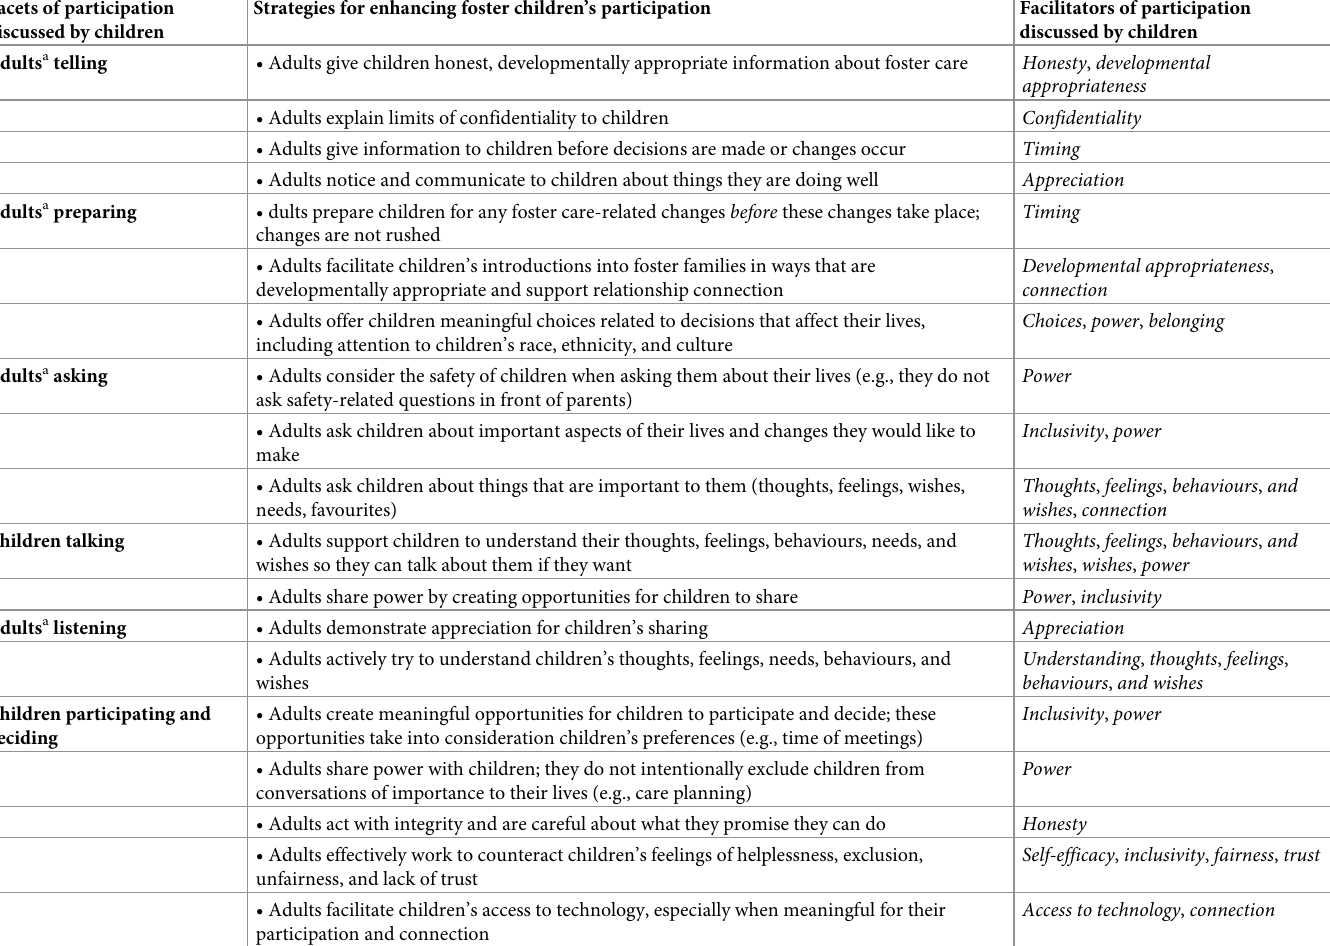
Table 3. Strategies for enhancing foster children’s